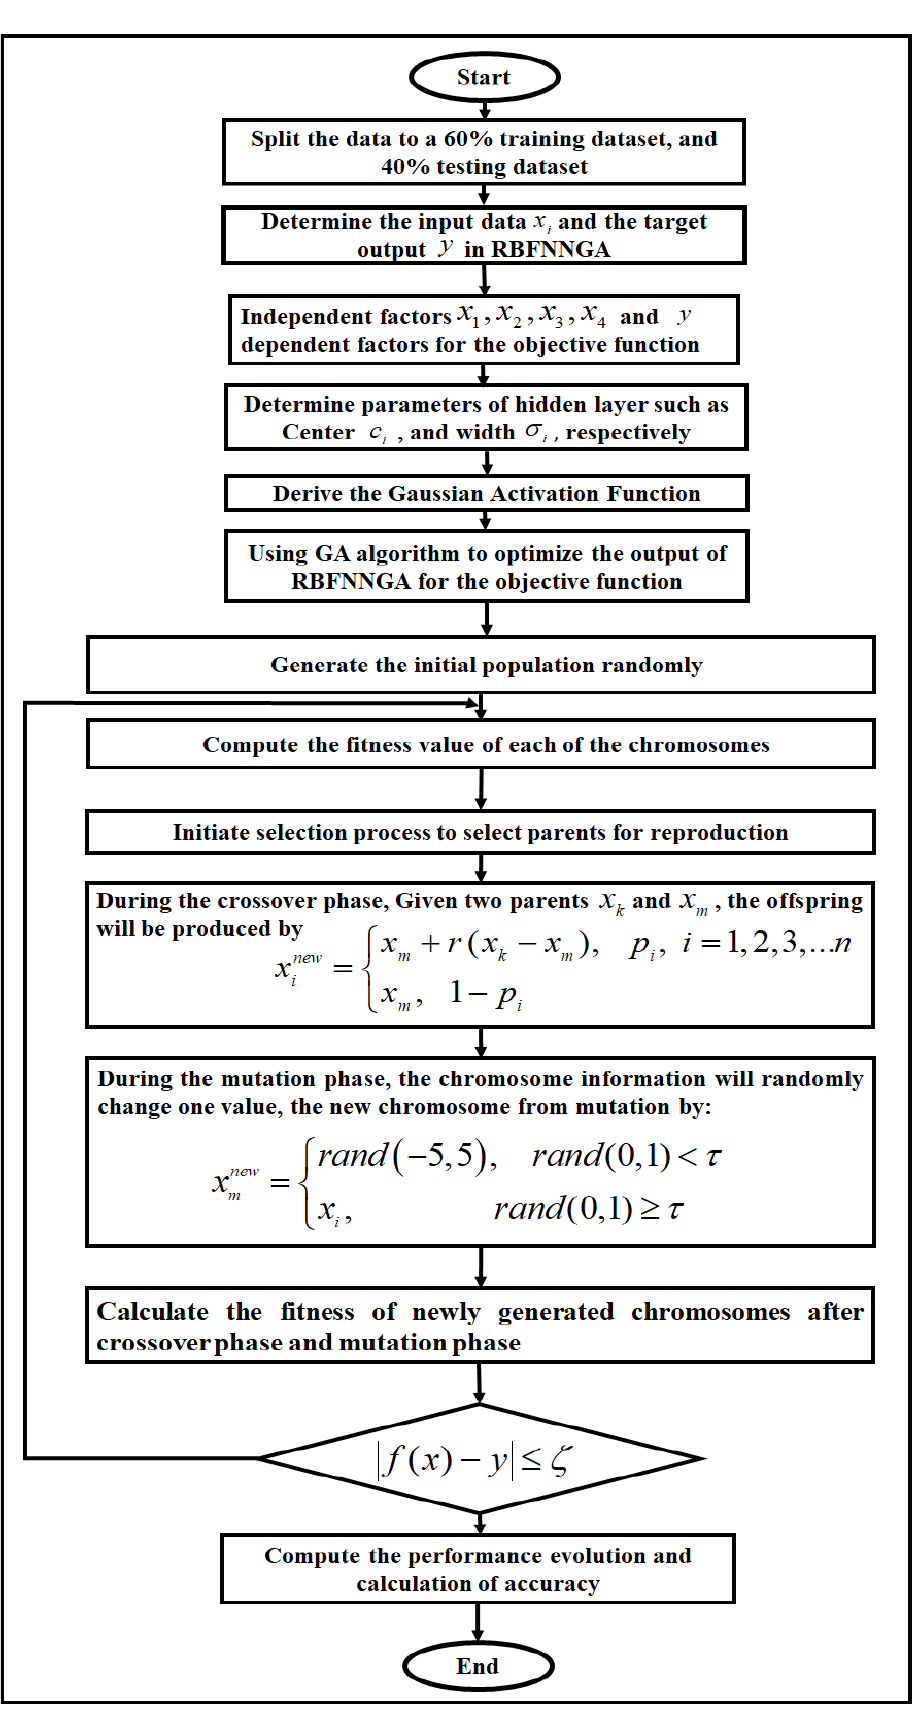
Figure 1. The RBFNN-GA flowchart.